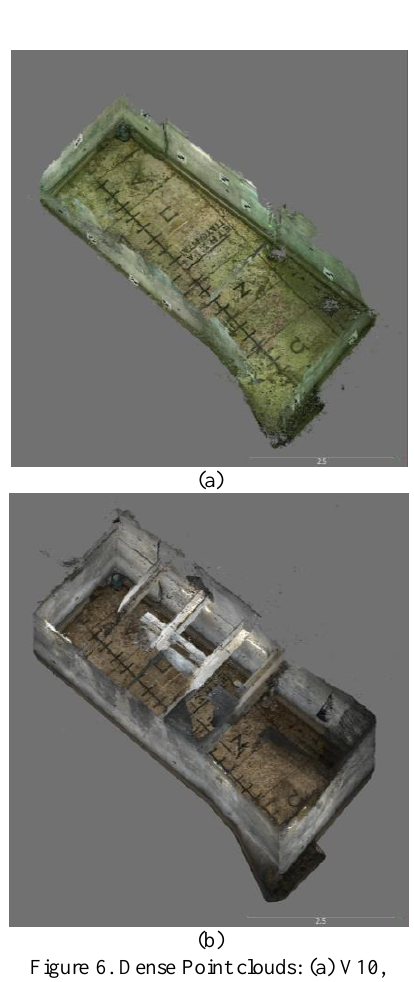
Figure 6. Dense Point clouds: (a) V10, (b) classical